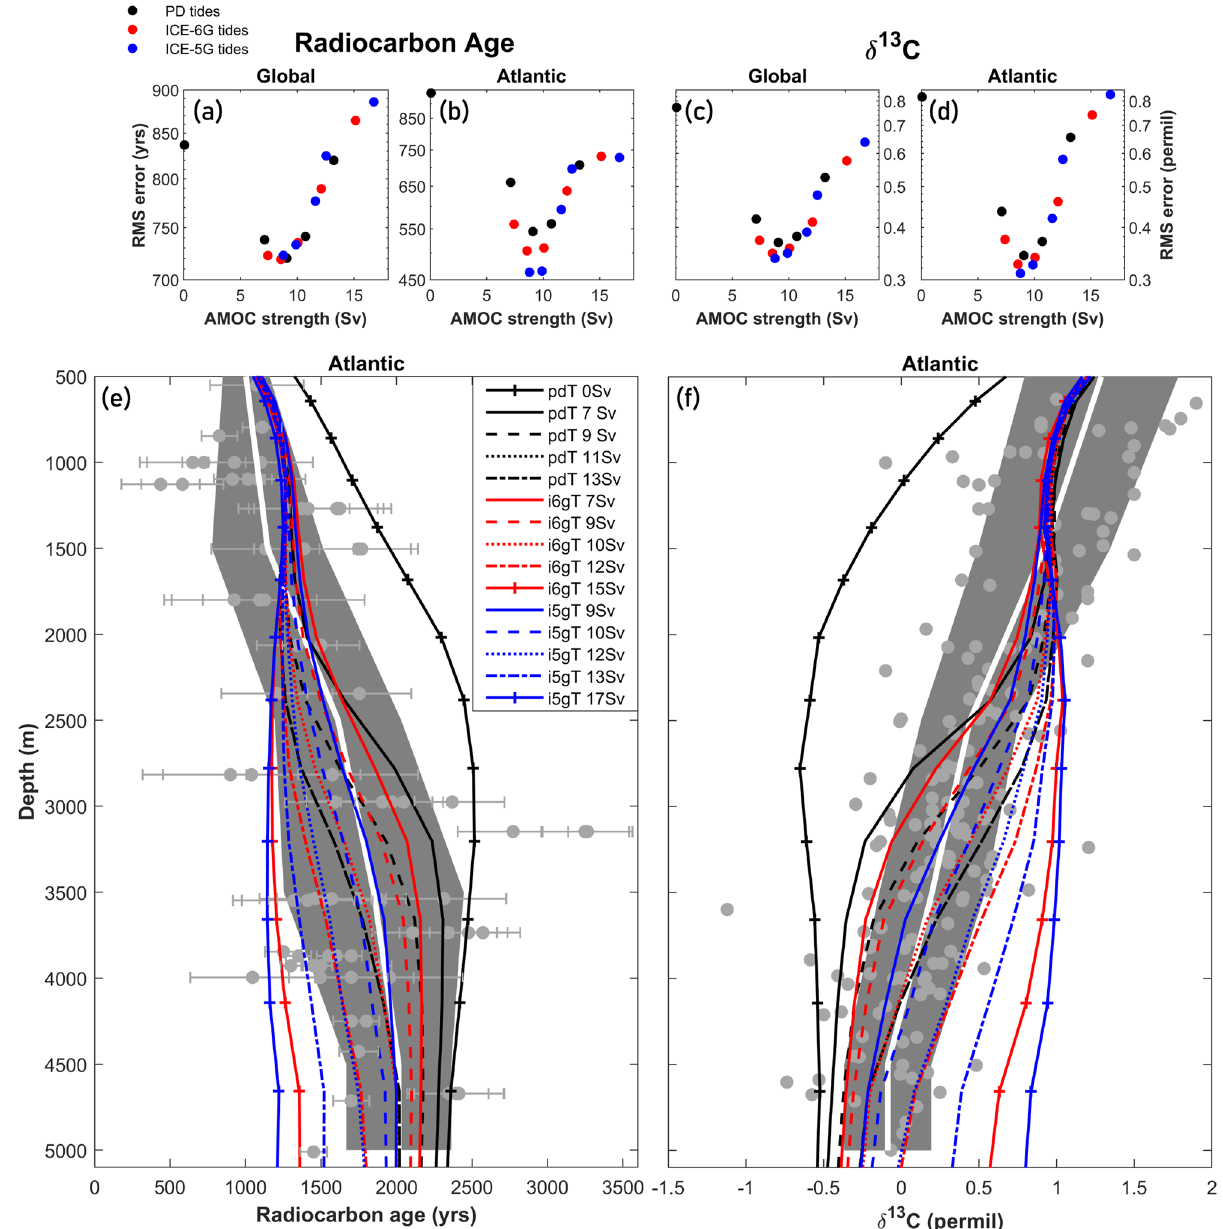
Fig. 4 Evaluation of modeled versus observational LGM radiocarbon and δ 13 C distributions. (Top panel) Evaluation of modeled versus observational radiocarbon ( a and b ) and δ 13 C ( c and d ) distributions plotted against Atlantic meridional overturning streamfunction (AMOC) strength for global (a and c ) and Atlantic (30°S – 50°N) ( b and d ) data. The data points are colored according to the tidal forcing applied in the respective simulation. Note the log-scale in panels ( a ) – ( d ) to distinguish the lowest root-mean-square (RMS) errors. (Bottom panel) Atlantic (30°S – 50°N) depth pro fi les of Last Glacial Maximum radiocarbon ( e ) and δ 13 C ( f ). The gray circle markers show observational data points. For the radiocarbon data points, the error bars represent a 1 σ uncertainty derived from the corresponding analytical uncertainties in radiocarbon dates and estimated uncertainties in reservoir ages 7 . The white line gives the mean value of the observations and the gray band indicates the + / − 1 standard deviation around the mean. Model-depth pro fi les for a subset of simulations are shown in black, blue and red and are colored according to the tidal forcing. The legend gives the corresponding AMOC